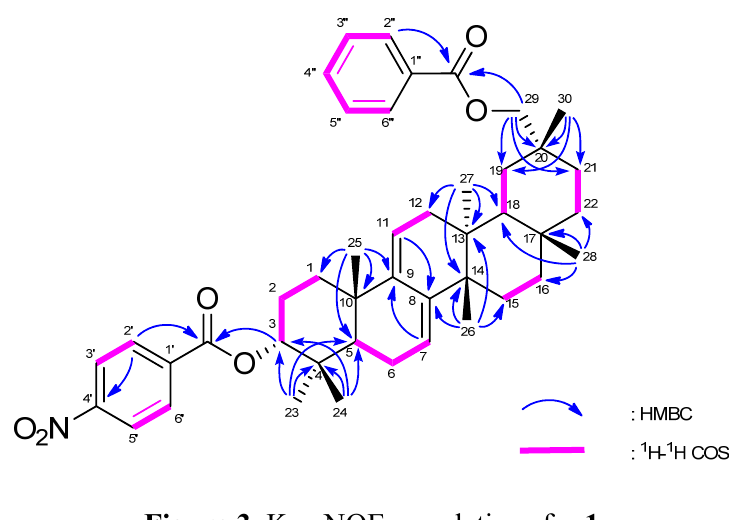
Figure 3. Key NOE correlations for 1